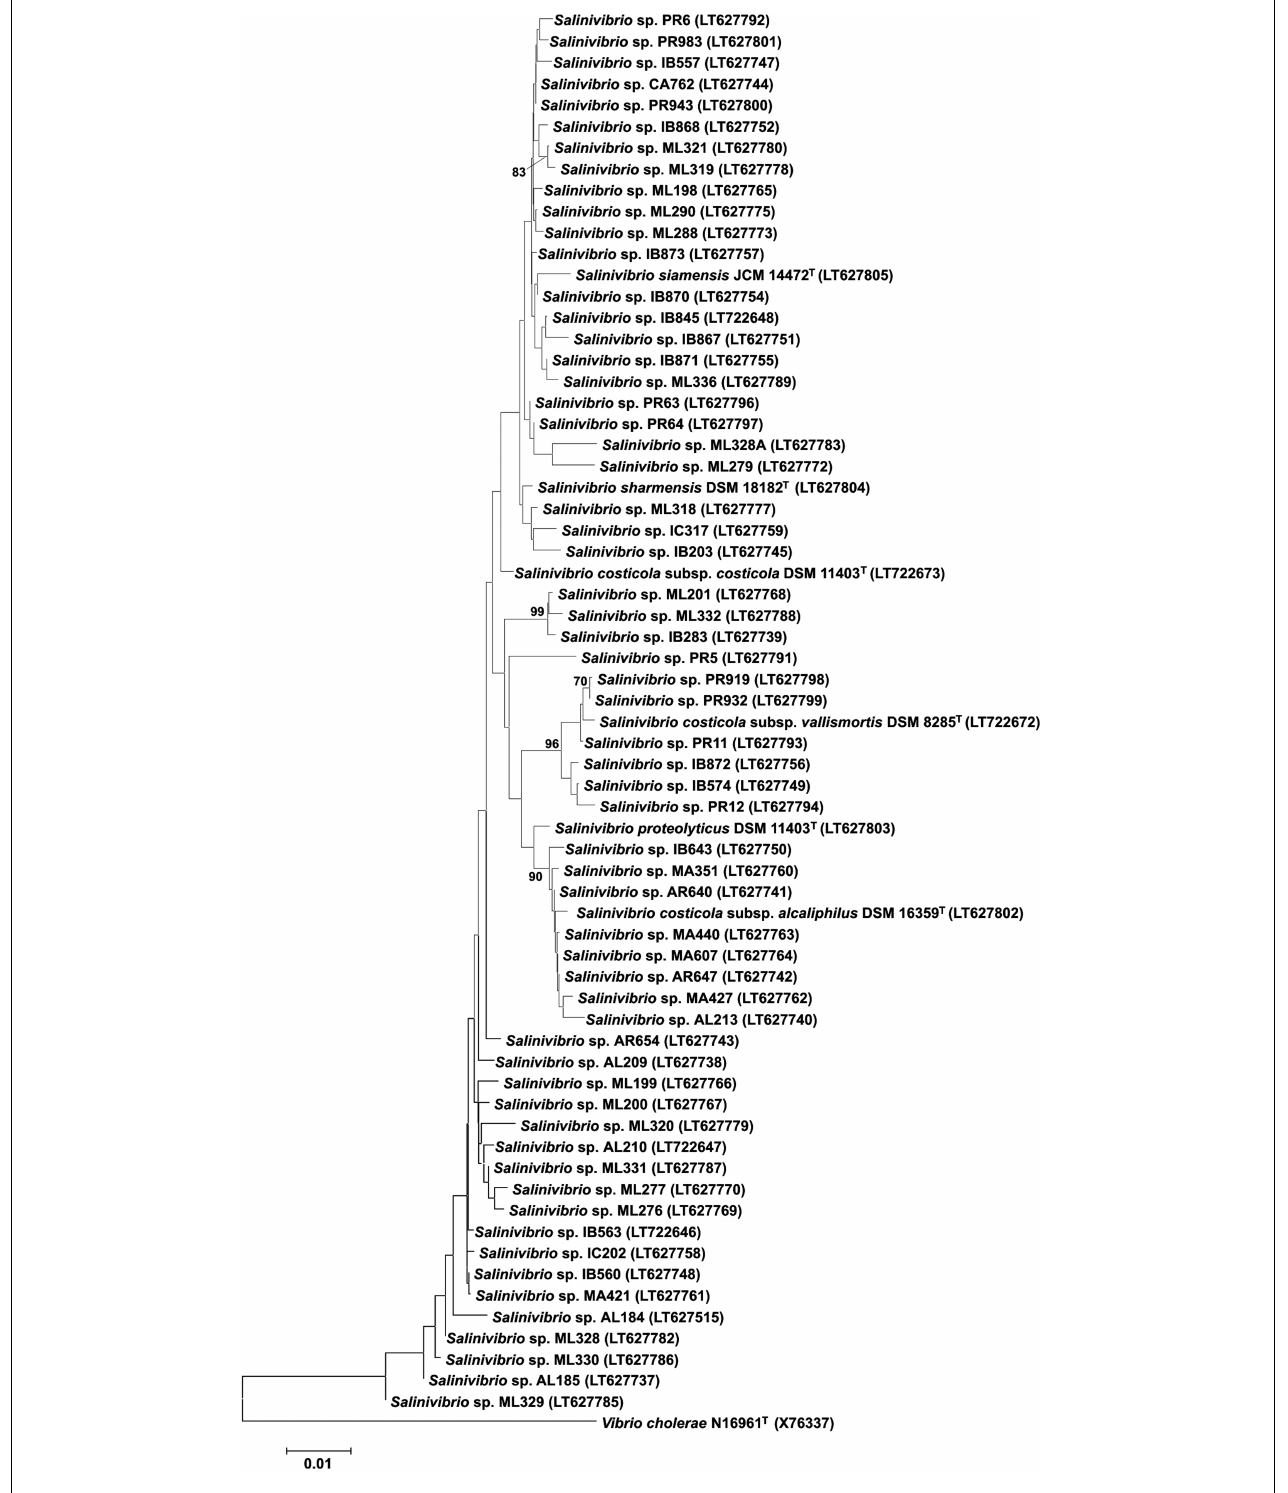
FIGURE 1 | Neighbor-joining tree based on nearly complete 16S rRNA gene sequences showing the relationships between isolated and type strains of the genus Salinivibrio . Filled circles indicate nodes that were also recovered in maximum-parsimony and maximum-likelihood trees based on the same sequences. Numbers at nodes are bootstrap support values (percentages) based on analyses of 1000 resampled datasets; only values above 70% are shown. The GenBank/EMBL/DDBJ accession number of each sequence is shown in parentheses. Bar, 0.01 nt changes per position. Vibrio cholerae N16961 T was used as an outgroup.